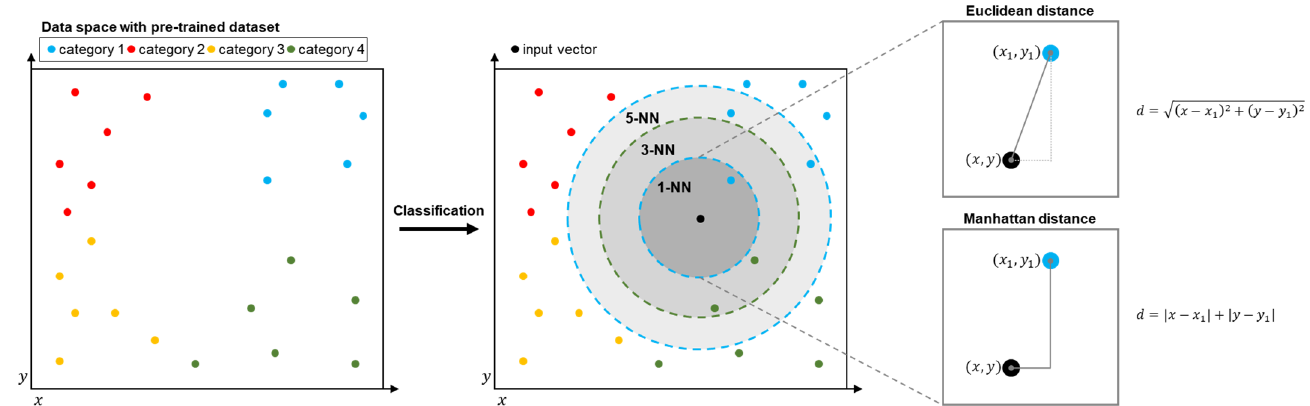
Figure 2. Visualization of the k-nearest neighbor algorithm. Algorithm 1 presents the classification process. During the classification, the k -NN algorithm finds a k number of data with the shortest distance in the trained dataset. After finding the nearest data, the algorithm extracts the most frequent category from a